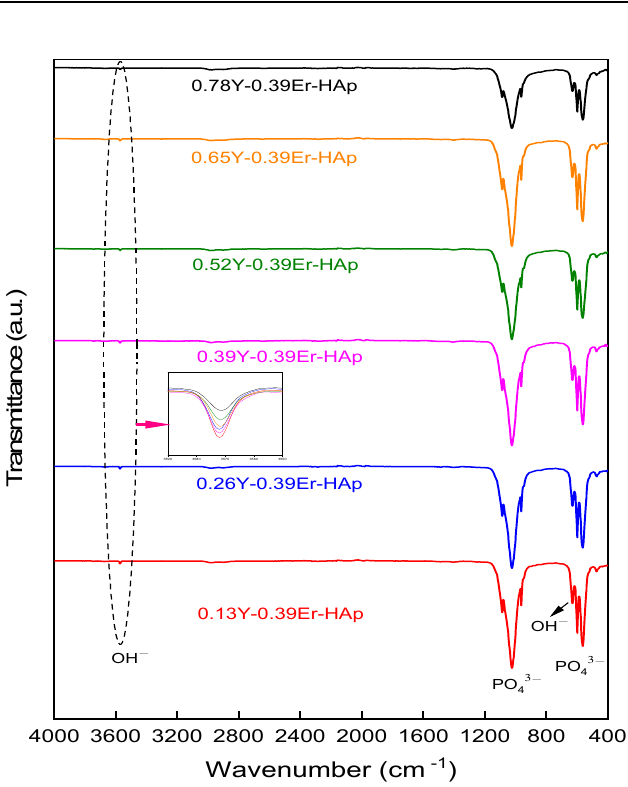
Figure 3. FTIR results of the as-prepared HAps.